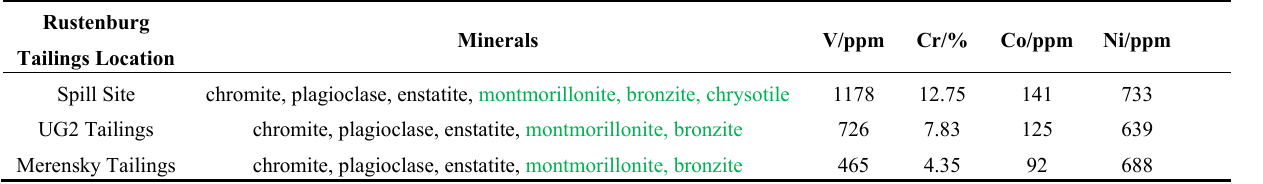
Table 2. Mineralogy derived from X-ray diffraction analysis (XRD) from the PGE tailings material in Rustenburg. Minerals detected by MICA analysis of ASD Fieldspec data are highlighted in green. X-ray fluorescence analysis (XRF) data of selected trace elements from the PGE tailings material in